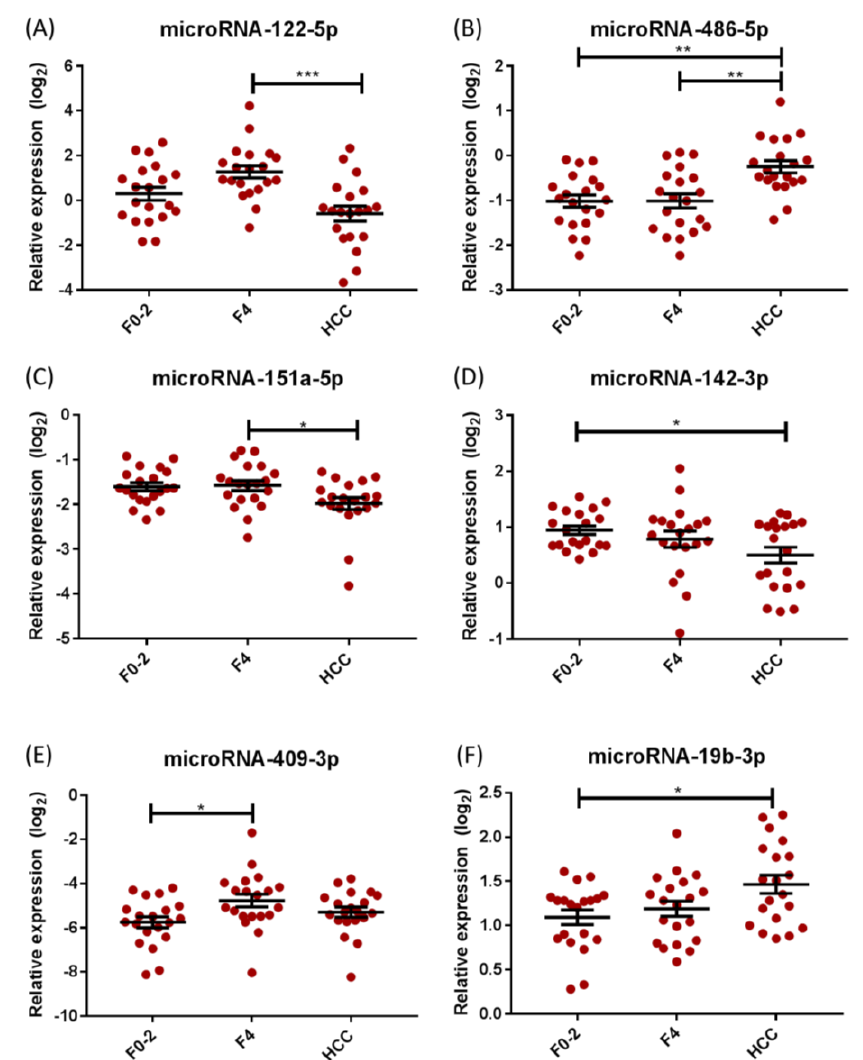
Figure 1. Association between circulating miRNA levels and severity of hepatic fibrosis and HCC in CHC. ( A ) miRNA-122-5p, ( C ) miRNA-151a-5p, and ( D ) miRNA-142-3p show a decreased expression